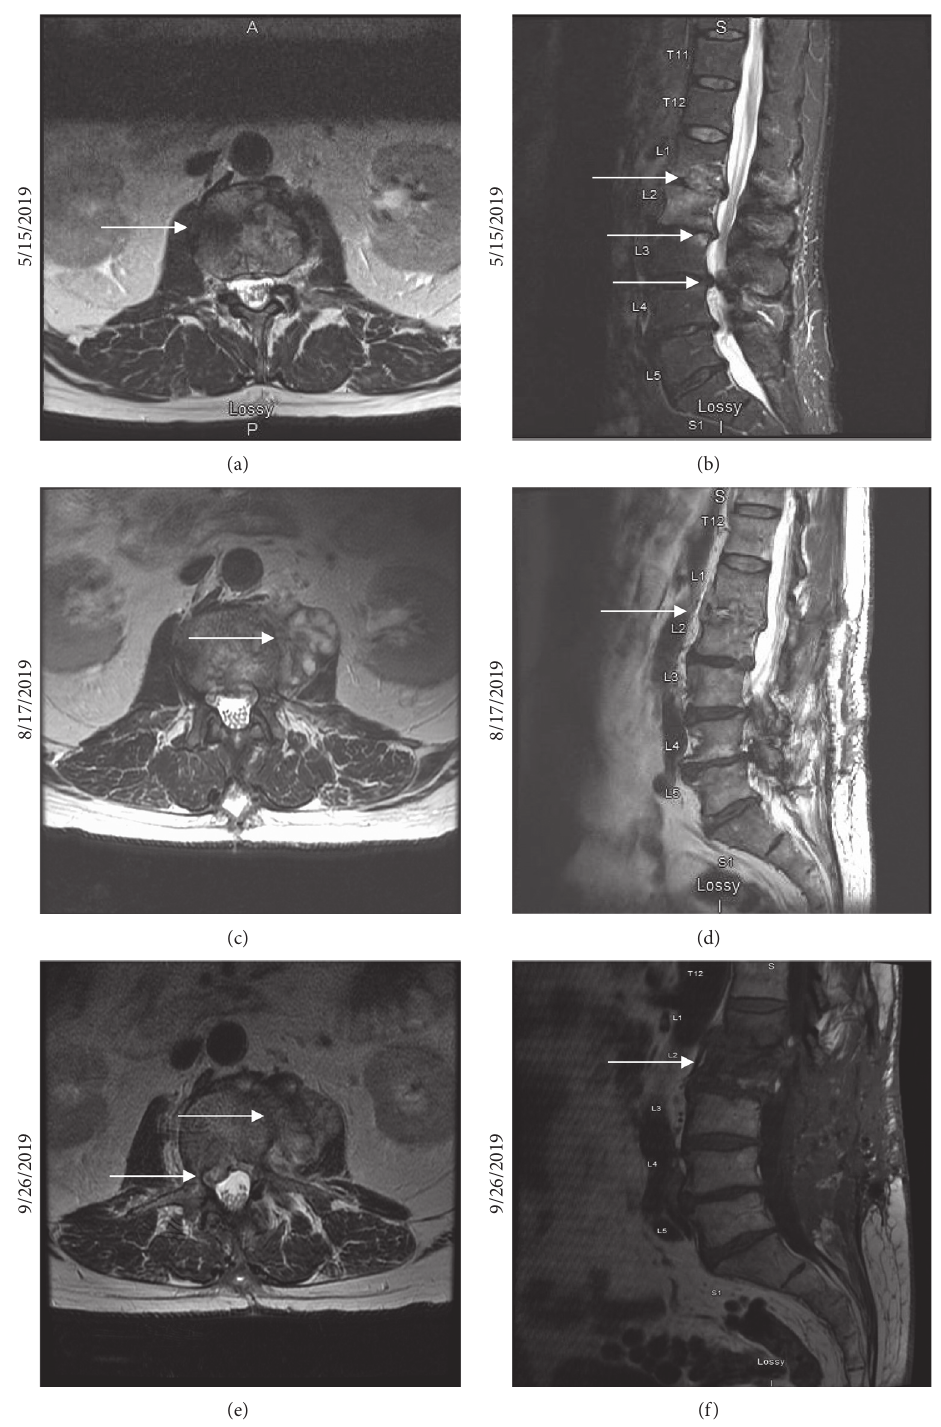
Figure 1: (a) An axial T2-weighted MRI image of morphological changes at the L1-L2 level presumed to be from degenerative process but difficult to distinguish from early infection. (b) A sagittal STIR MRI image showing multilevel degenerative changes resulting in severe canal stenosis particularly at the L2-L3 and L3-L4 levels. The morphological changes observed in Figure 1(a) are also visible. (c) An axial T2- weighted MRI image showing a heterogenous left paraspinal spinal mass with solid and cystic components. These findings raise concern for a potentially neoplastic process superimposed on an atypical infection. (d) A sagittal T1-FLAIR MRI image showing progressive, extensive degeneration at the L1-L2 and L3-L4 levels since prior study, suggesting infectious etiology. (e) An axial T1 FS post-MRI image showing 2 new small nonenhancing abscesses within the left psoas muscle and right L2-L3 paraspinal phlegmon. This epidural phlegmon, together with the microabscesses, caused an apparent impingement of the right L2 nerve at the right proximal margin of the right L2-L3 neural foramen. (f) A sagittal T1 MRI image showing L1-L2 discitis and vertebral, endplate osteomyelitis of